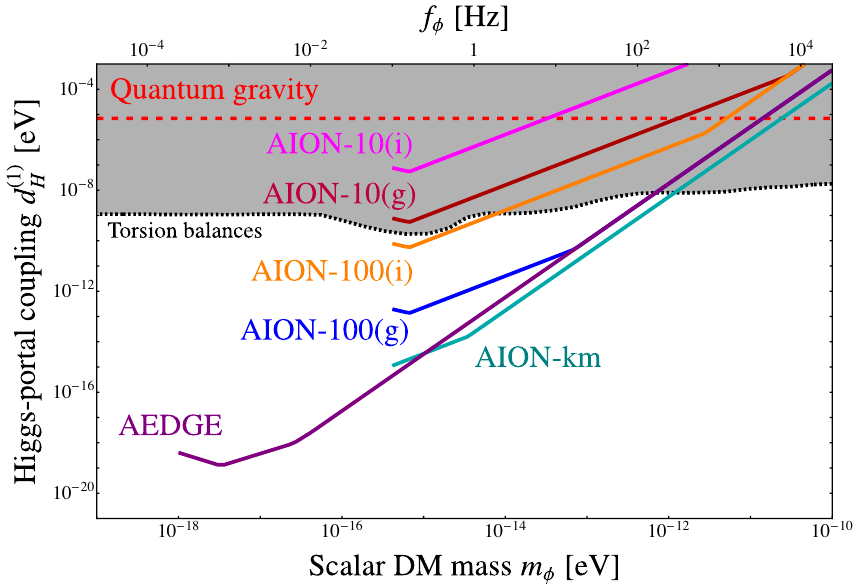
( 1 ) . Quantum gravity predicts d ( 1 ) H